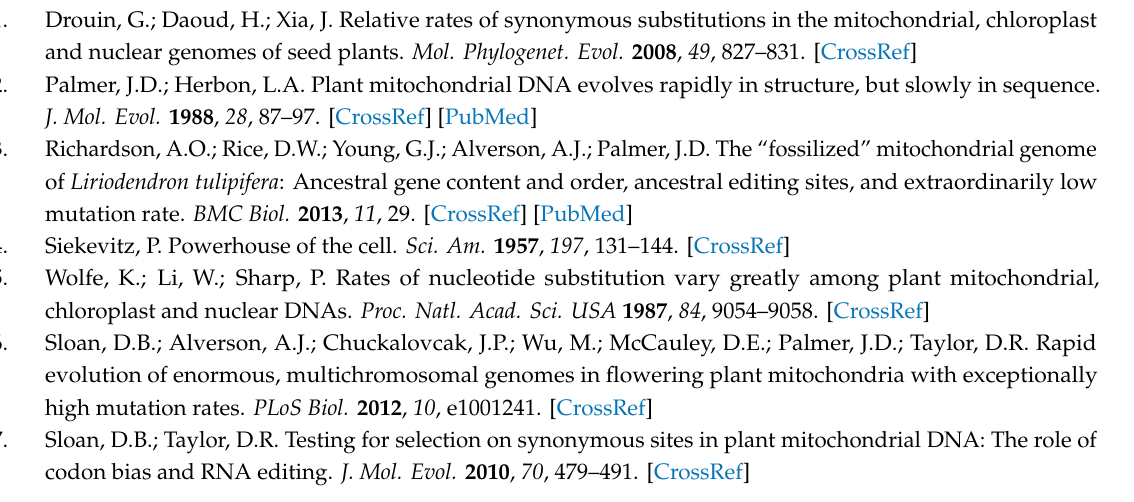
Figure S1: Mitochondrial targeting of a GFP labeled MTP-APOBEC3G construct, Table S1: Primers for RT-PCR, Table S2: qPCR primer e ffi ciency, Table S3: Primers for ROUS recombination assay, Supplementary File 2: SNP analysis